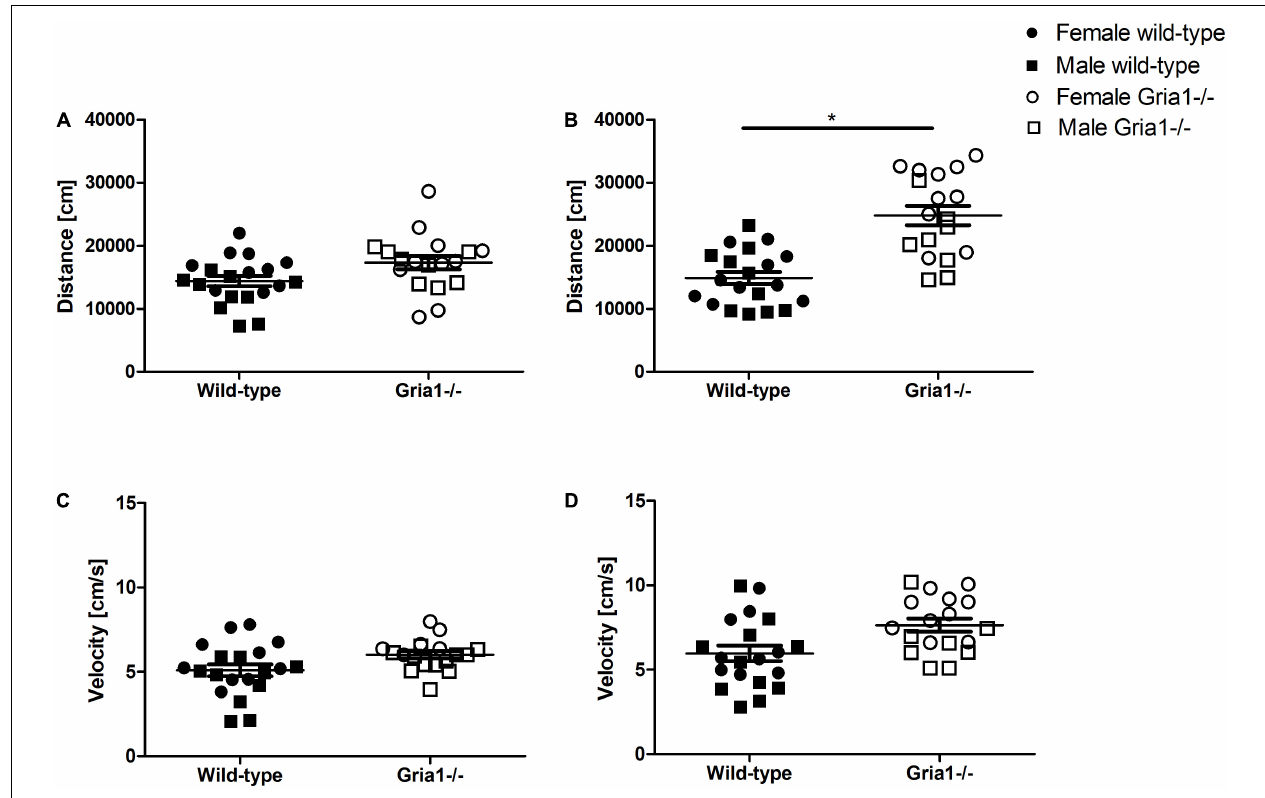
FIGURE 6 | Bench-top assessment focusing on overall activity. We analyzed the overall activity focusing on the total distance moved and the velocity of movement in the PhenoTyper cages. The distance moved by prepubescent (A) and sexually mature (B) mice during the 60-min observation interval was significantly affected by genotype only in sexually mature mice. For the velocity of movement in prepubescent (C) and sexually mature (D) mice, a significant effect of genotype could not be confirmed. ANOVA, followed by FDR correction. n = 8–10 per genotype per sex. * p < 0.05. Error bars indicate the standard error of the mean